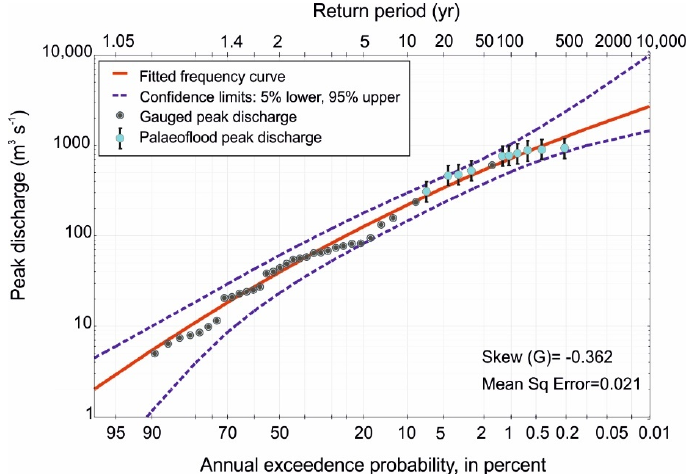
Figure 10. Log-Pearson 3 distribution fitted with systematic and palaeoflood data. Dots are plotting positions for the systematic (black dots) and palaeoflood records (blue dots with vertical lines).